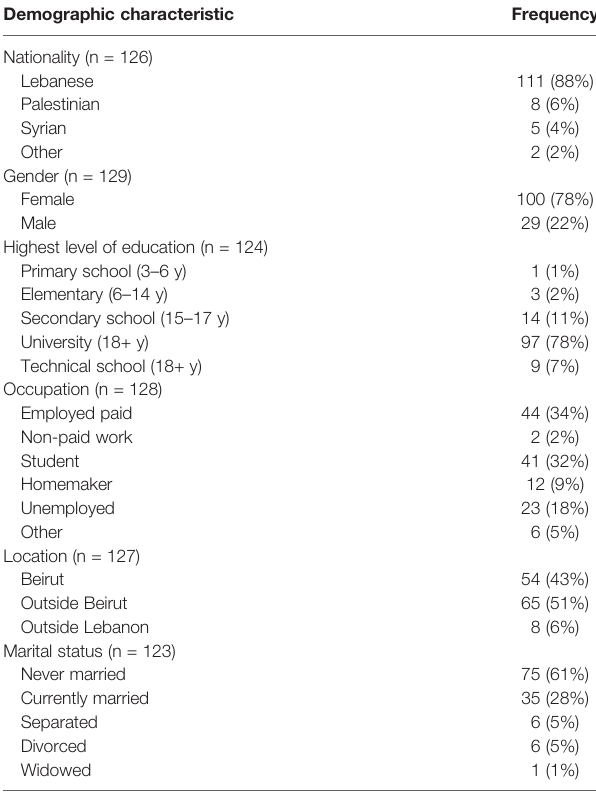
TABLE 1 | Characteristics of study participants who chose to provide demographic